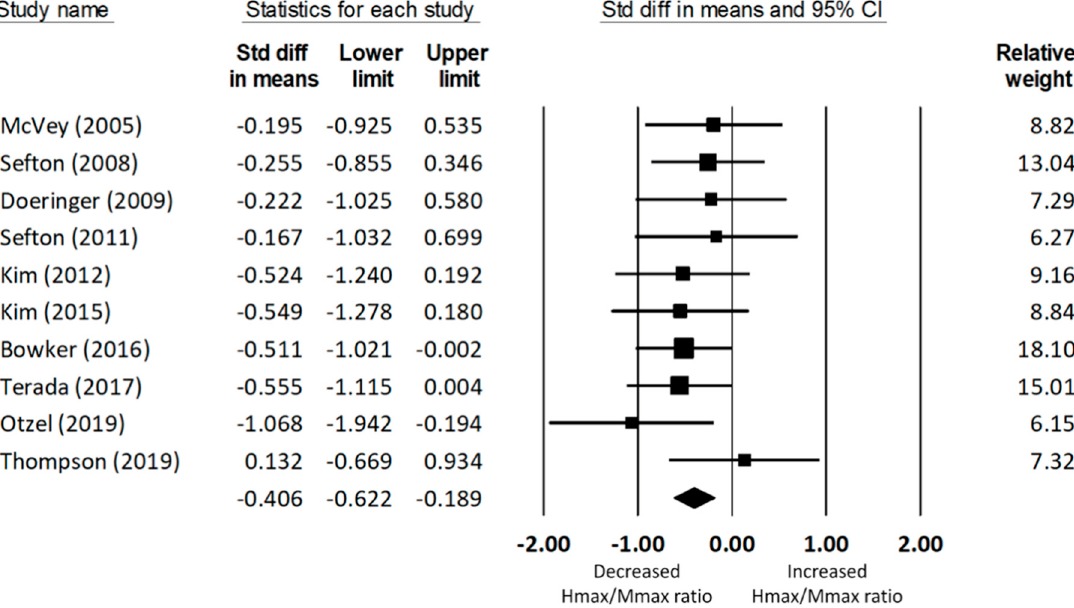
Figure 2. Forest plot illustrating Cohen’s d effect sizes for the soleus Hmax/Mmax ratio between groups with and without CAI and their 95% confidence intervals.